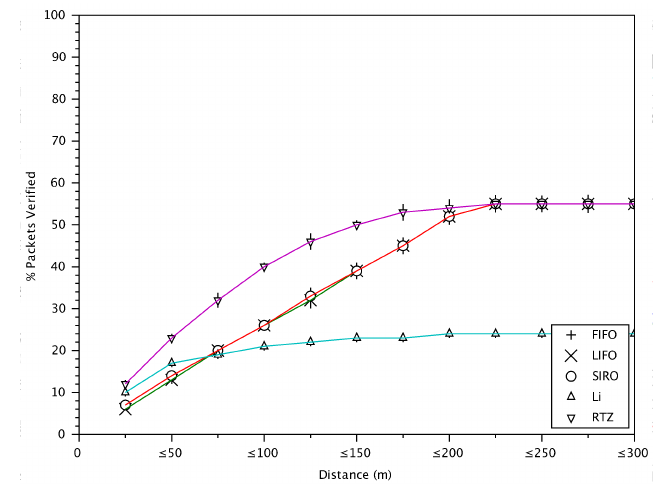
Figure 9. The cumulative percentage of verified messages with respect to distances between transmitting and receiving